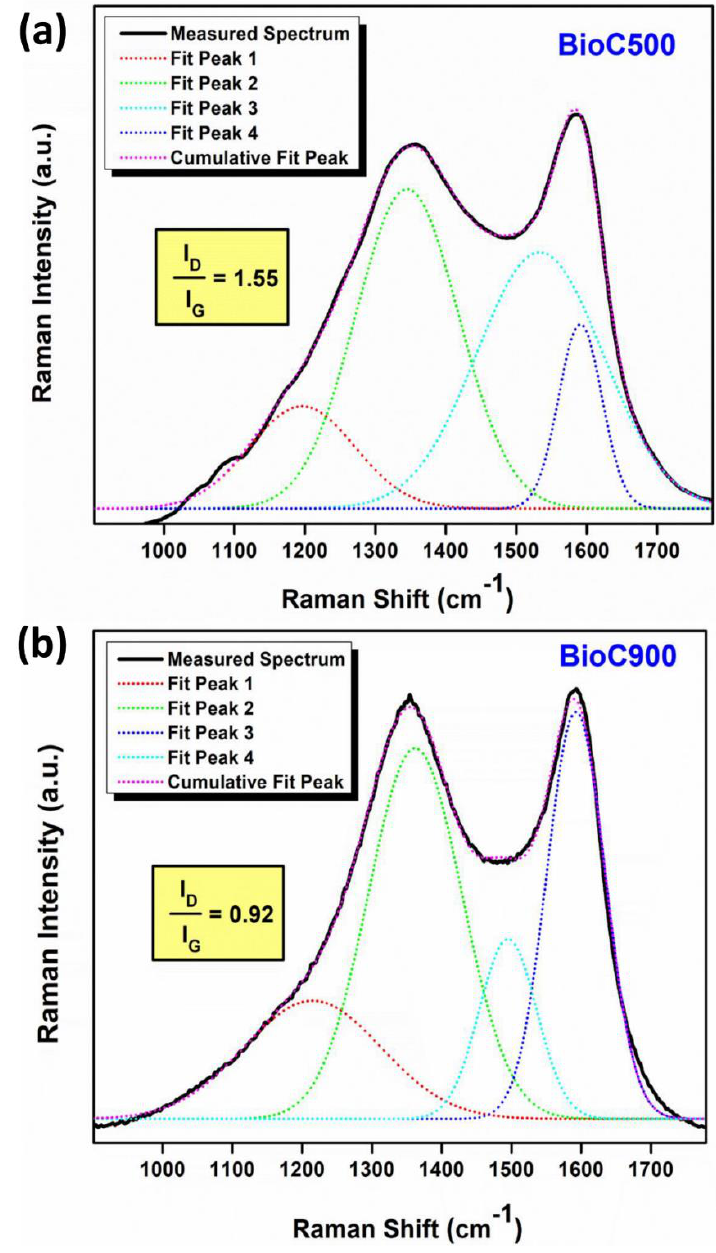
Figure 2. Raman spectroscopy of ( a ) 500 °C and ( b ) 900 °C soy hull biocarbon.